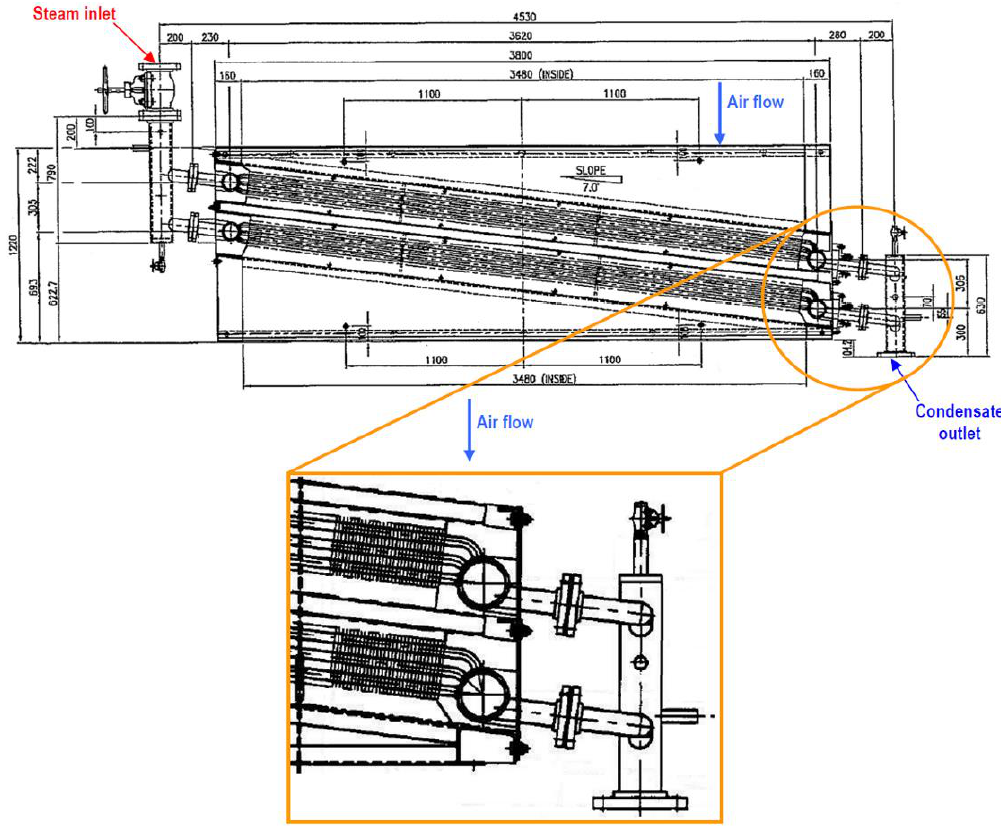
Figure 1. Cross-section of the analyzed steam air heater with main overall dimensions.